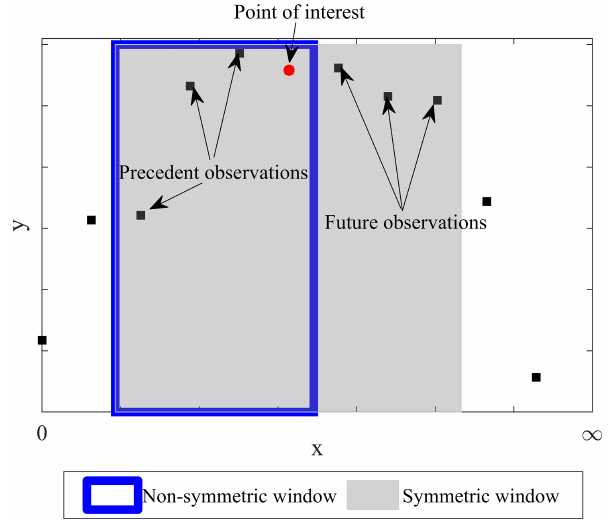
Figure 4. Concept of symmetric and non-symmetric window types in the filtration